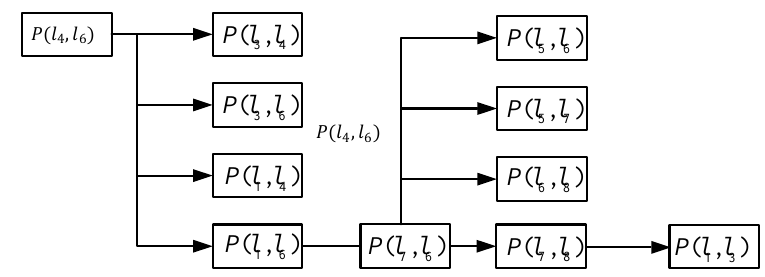
Figure 10. Recursive relationship between instant center points.